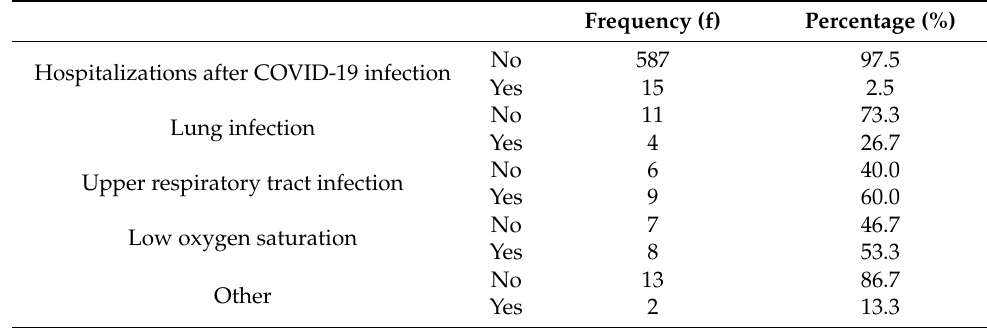
Table A3. Hospitalizations and problems encountered after COVID-19